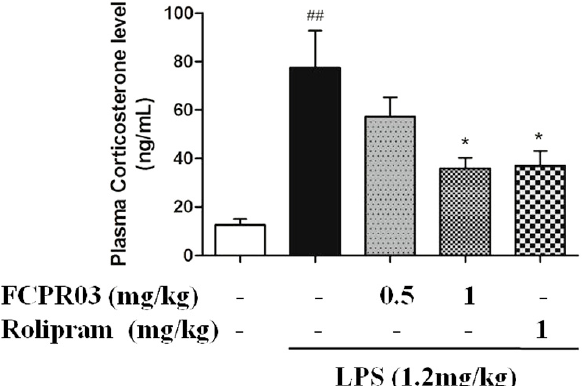
Figure 5. FCPR03 decreased the level of plasma corticosterone in mice challenged with LPS. After seven consecutive days of pretreatment with FCPR03 (0.5 mg/kg or 1 mg/kg) or rolipram (1 mg/kg), mice were injected i.p. with saline or LPS (1.2 mg/kg, i.p.); 24 h after LPS injection, the level of plasma corticosterone were measured by ELISA. Data are expressed as the mean ± SEM. ## p < 0.01 compared with control group; * p < 0.05 compared with LPS group ( n = 8 per group).